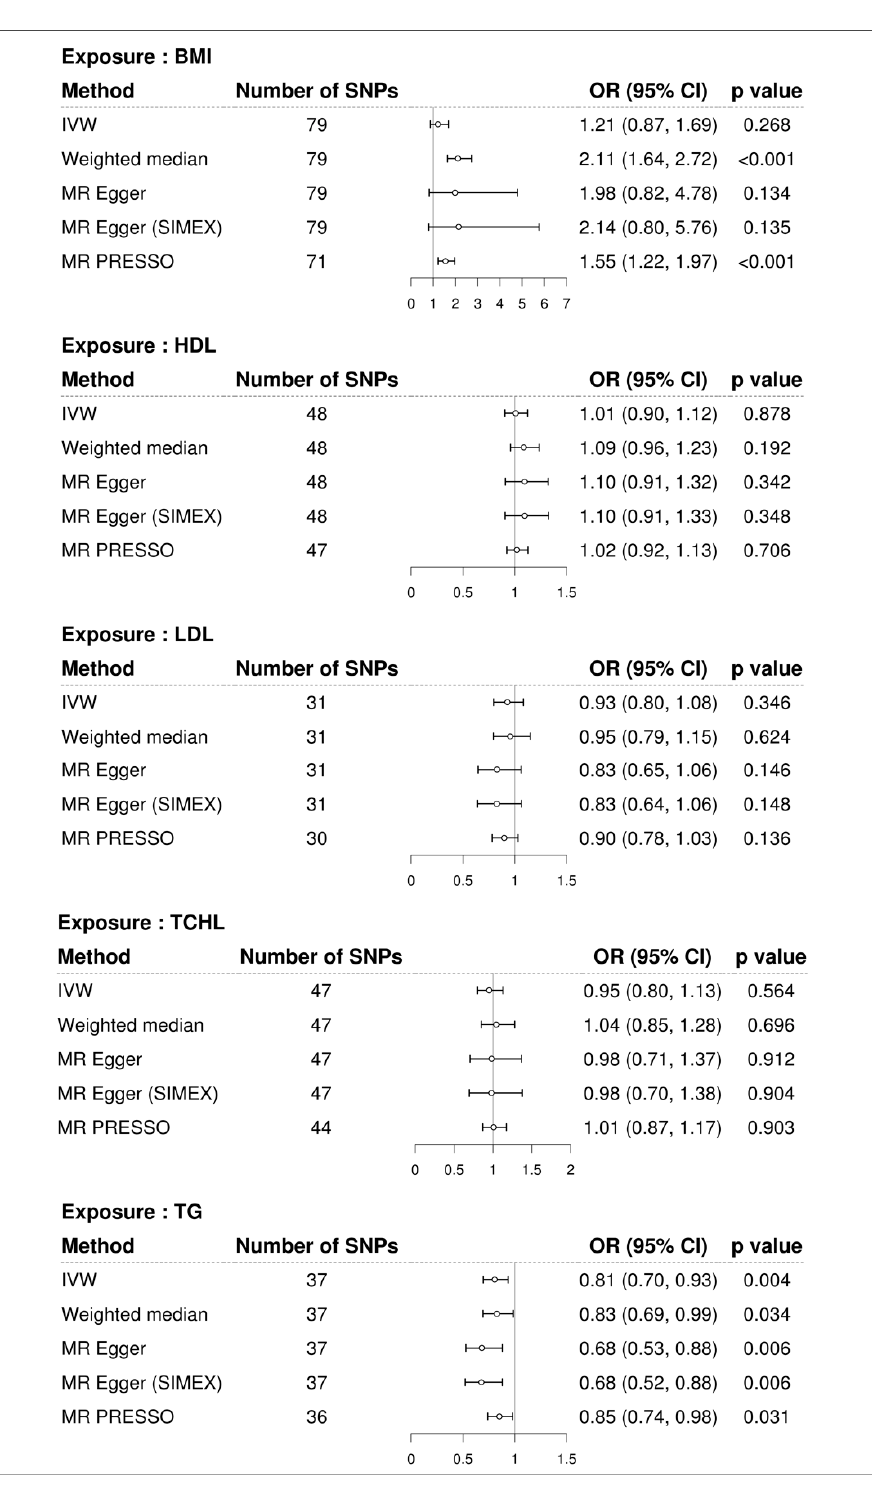
Figure 2. Forest plot of causal associations of BMI and dyslipidemia with T2D. BMI: body mass index; T2D: type 2 diabetes; SNP: single nucleotide polymorphism; OR: odds ratio; CI: confidence interval; IVW: inverse-variance weight; MR: Mendelian randomization; SIMEX: simulation extrapolation; PRESSO: polyhedral sum of residuals and outliers; HDL: high-density lipoprotein cholesterol; LDL: low-density lipoprotein cholesterol; TCHL: total cholesterol; TG: